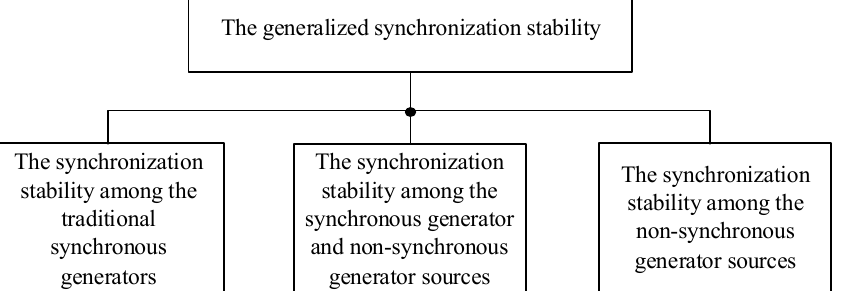
Figure 1. The implication of the generalized synchronization stability.